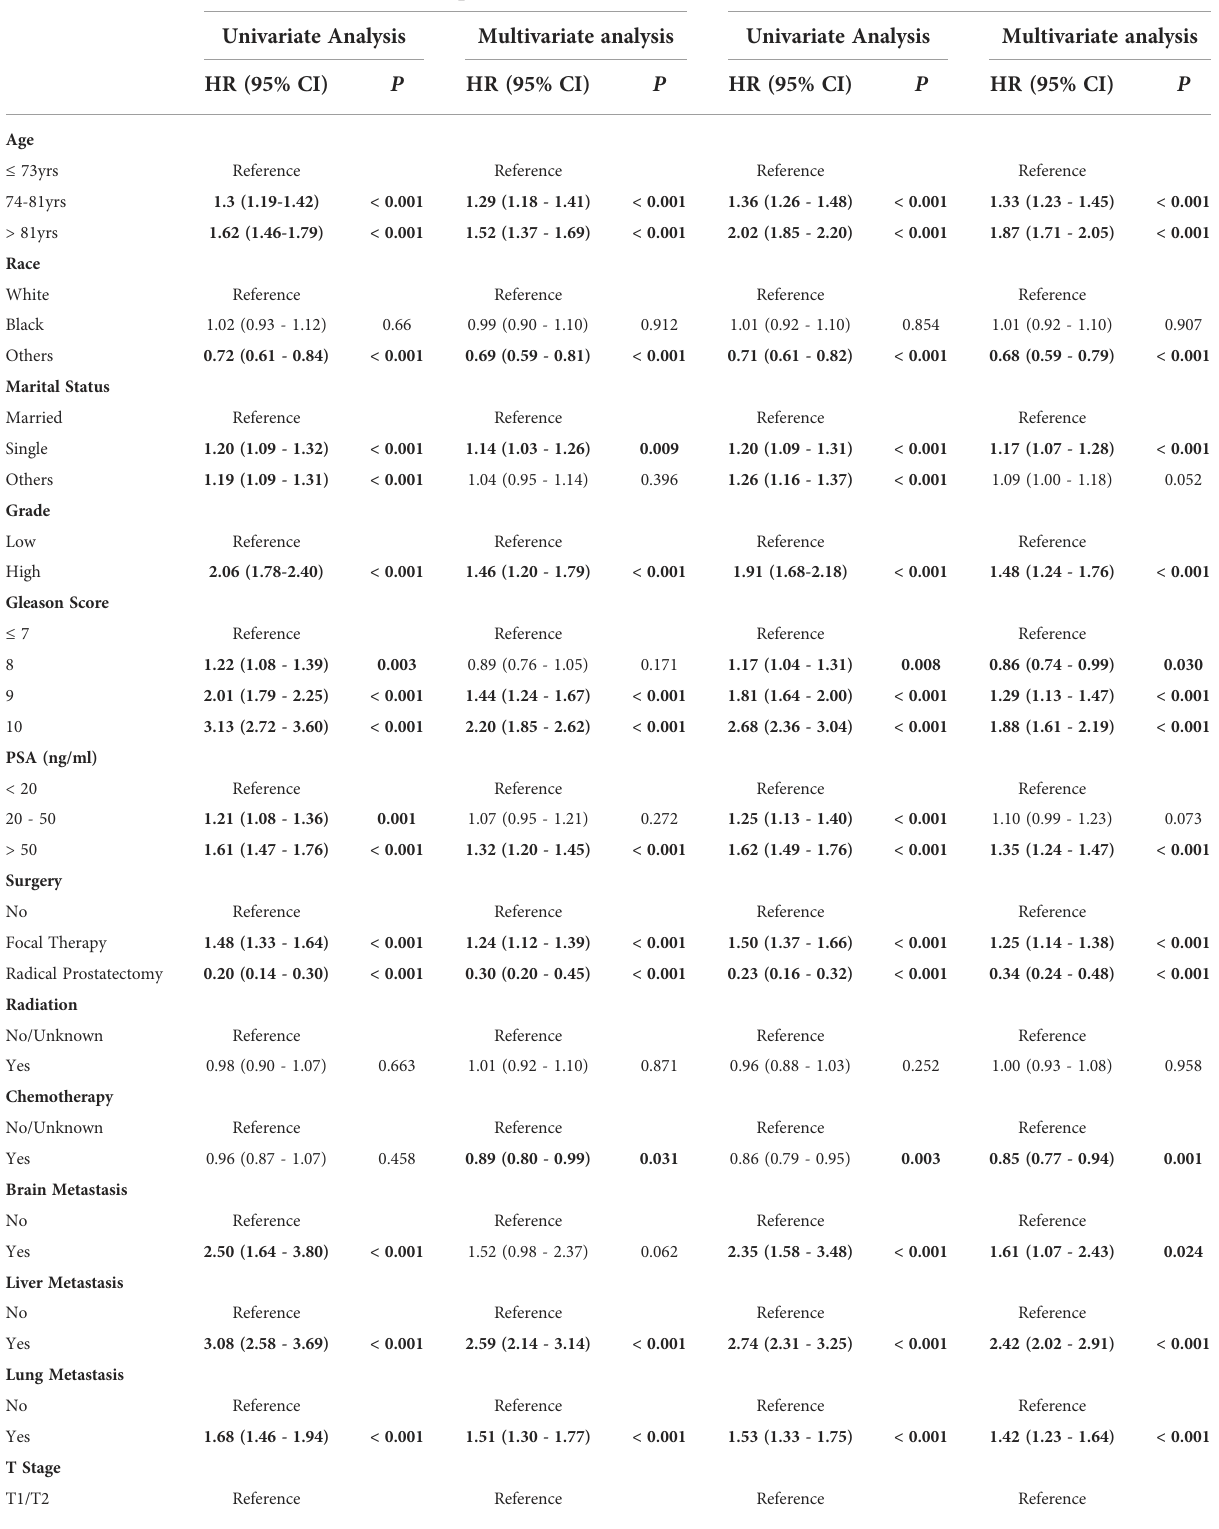
TABLE 2 Univariate and multivariate analysis of CSS and OS for PCa patients with BM. Variables Prostate Cancer-Speci fi c Survival Overall Survival Univariate Analysis Multivariate analysis Univariate Analysis Multivariate